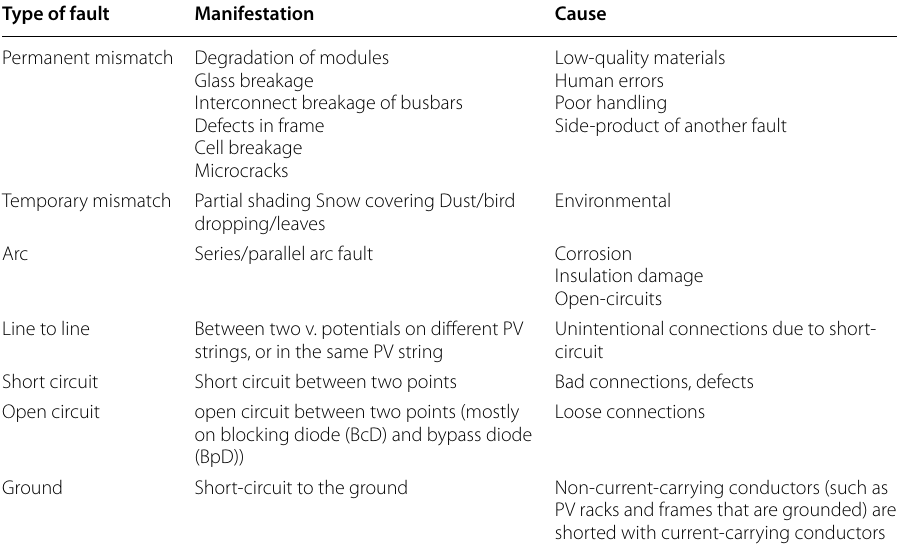
Table 1 Common types of dc faults and their causes [20] Type of